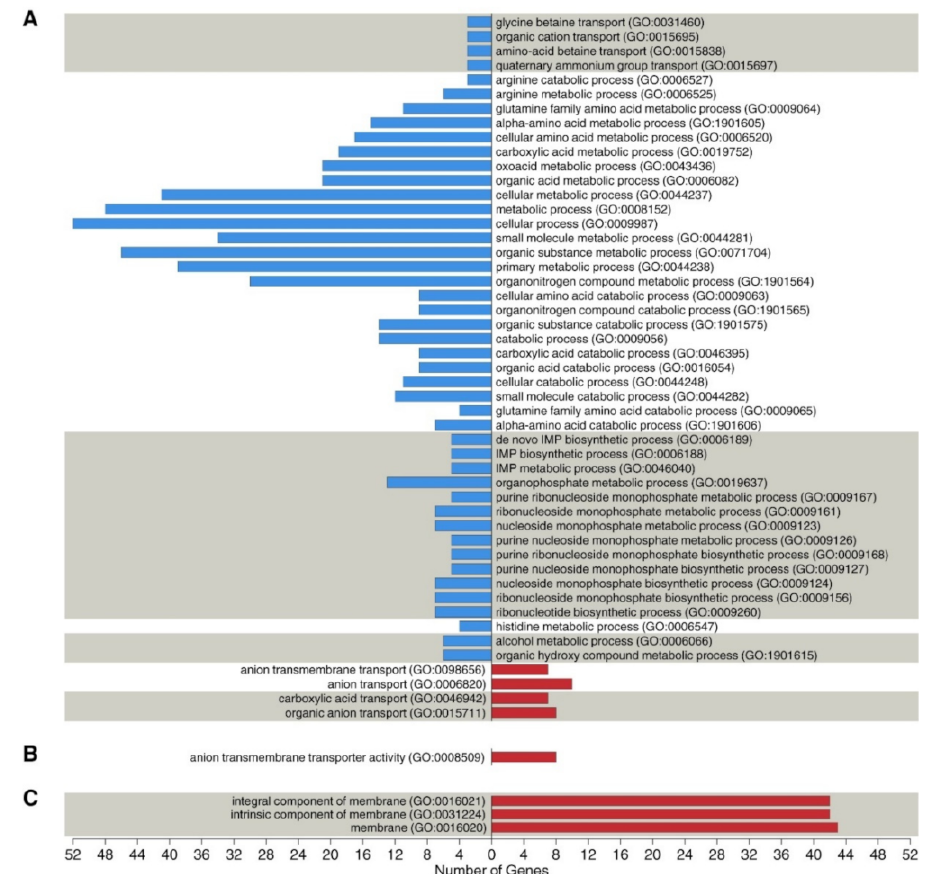
Figure 2. Gene Ontology (GO) enrichment analysis of host differentially expressed genes (DEGs) (up- and downregulated genes) in the early stage of infection (5 min). ( A ) biological processes; ( B ) molecular function; ( C ) cellular component. Enriched GO terms for DEGs colored by red and blue. Red bars indicate terms enriched in the upregulated DEGs. Blue bars represent terms enriched in the downregulated